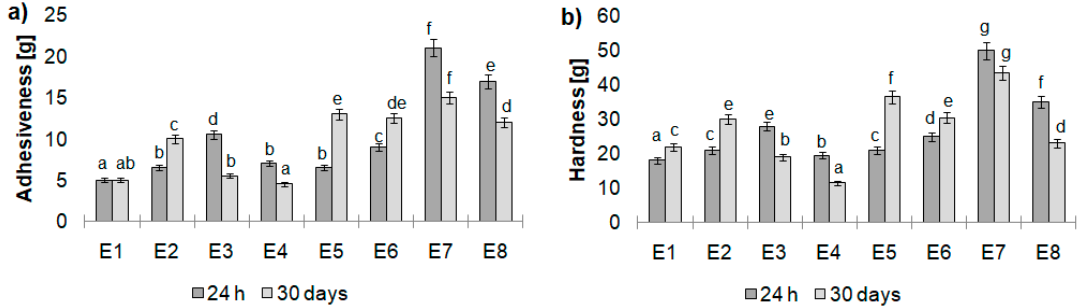
Figure 8. Texture analysis ( a ) adhesiveness and ( b ) hardness of examined emulsions after 24 h and 30 days of storage. Different letters indicate statistically significant difference ( p < 0.05).